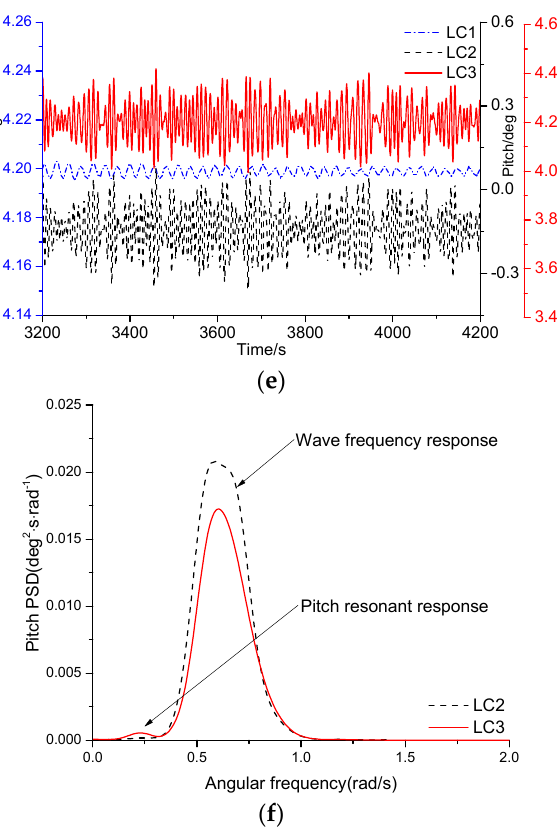
Figure 9. Power spectra and time histories of the platform motions for different load cases. ( a ) Time histories of surge motion; ( b ) power spectra of surge motion; ( c ) time histories of heave motion; ( d ) power spectra of heave motion; ( e ) time histories of pitch motion; ( f ) power spectra of pitch motion.